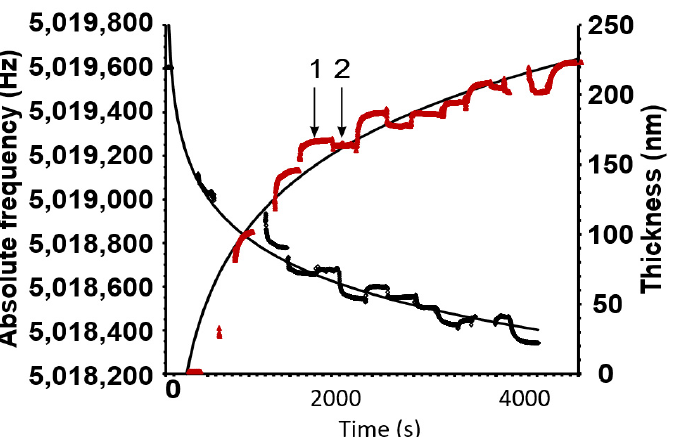
Figure 1. The black curve shows the decrease in frequency as the different polymers are sorbed. The red curve indicates the increase in thickness of the total amount of sorbed polymers. The number 1 represents the excess sorption when the crystal is dipped into a polymer solution. After dipping, the crystal is washed to remove the excess, and at 2, the remaining layer thickness can be found. Conversely, the frequency shows a proportional but negative trend.